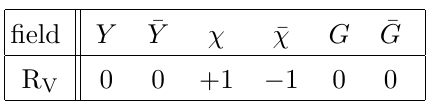
Table 2 . The vector R-charges of (cid:12)elds in a LG